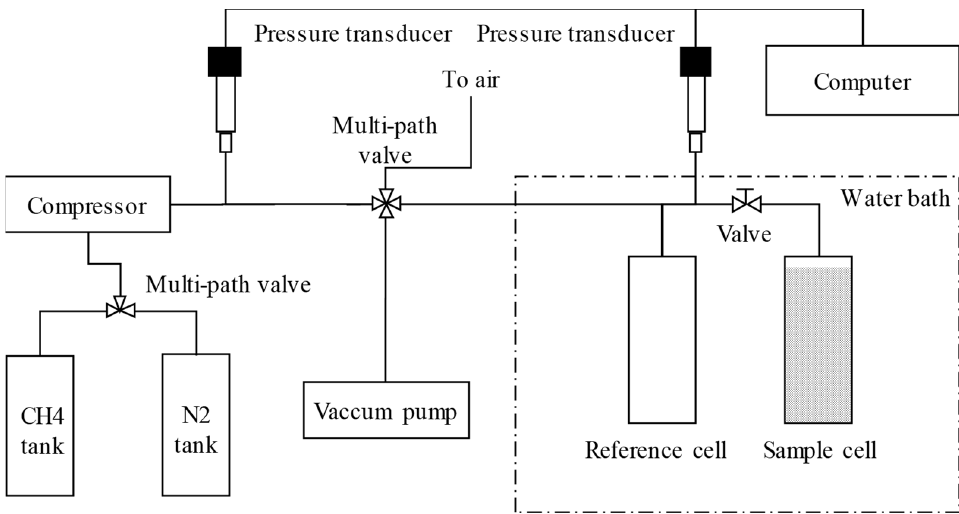
Figure 1. Schematic diagram of experimental apparatus.